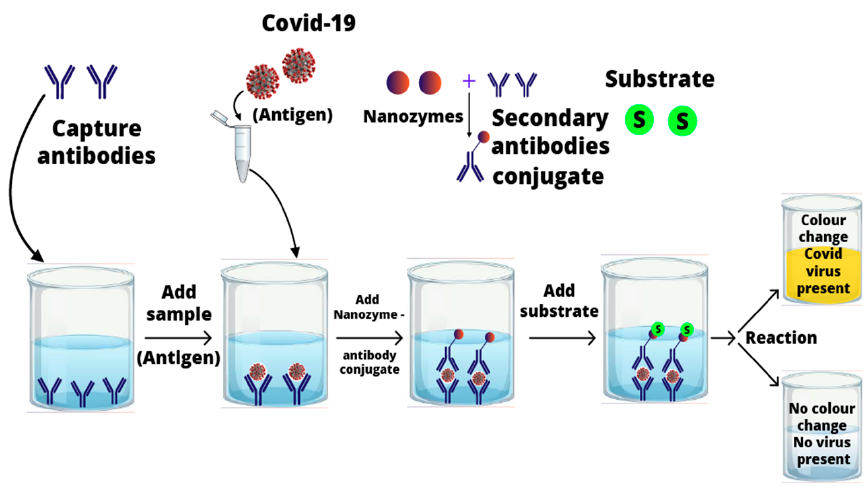
Figure 2. Possible mechanism of nanozyme-mediated sandwich enzyme-linked immunosorbent assay (ELISA) for SARS-CoV-2 detection.